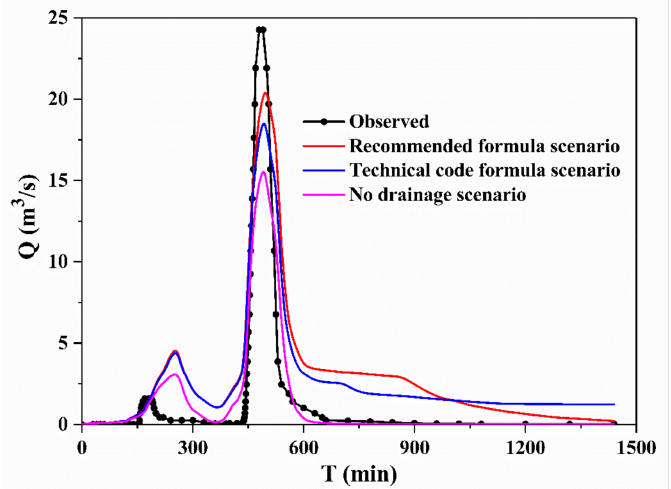
Figure 10. Comparison of the simulated hydrograph and observed data under the 3